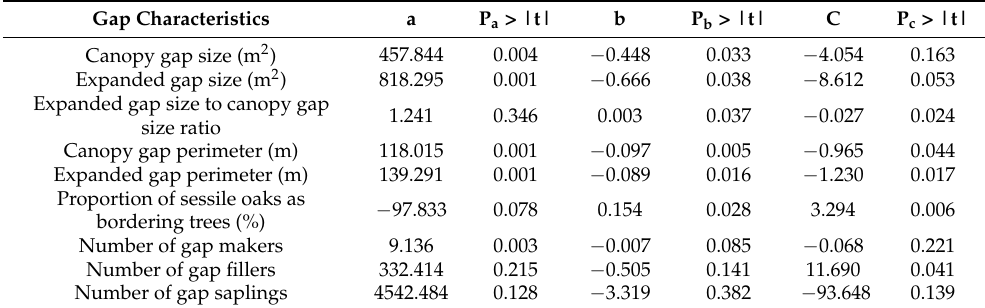
Table 2. Influence of altitude and slope on gap characteristics. a, b and c represent the model coefficients (gap characteristic = a + b × Altitude + c × Slope ), and p a , p b and p c represent the probability ( p -value) for the two-tailed t -test (prob > |t|) used to test the significance of the model coefficients. Gap Characteristics a P a > |t| b P b > |t| P c >